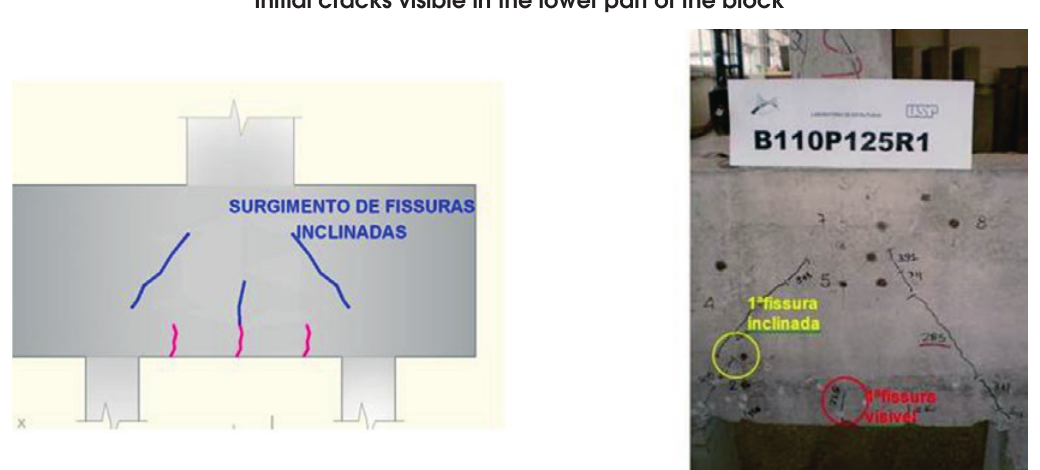
Emergence of inclined